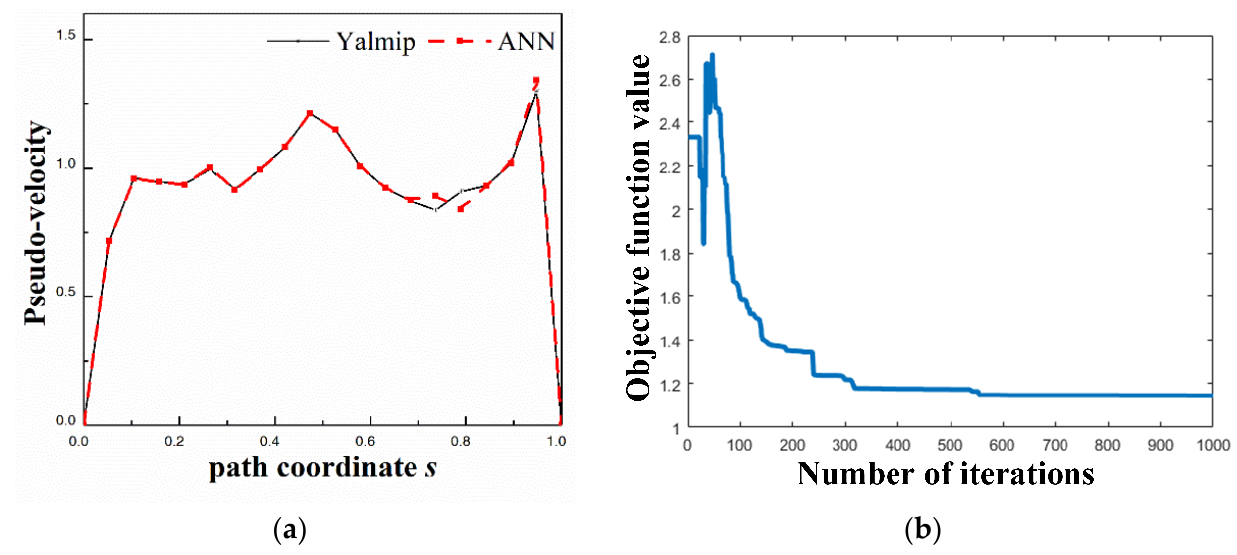
Figure 4. Optimized results for robot joint solved by Yalmip with the method in reference and the proposed method using ANN. ( a ) Optimization variable h ( s j ) values at different coordinates; ( b ) Convergence curve of optimization objective with ANN.